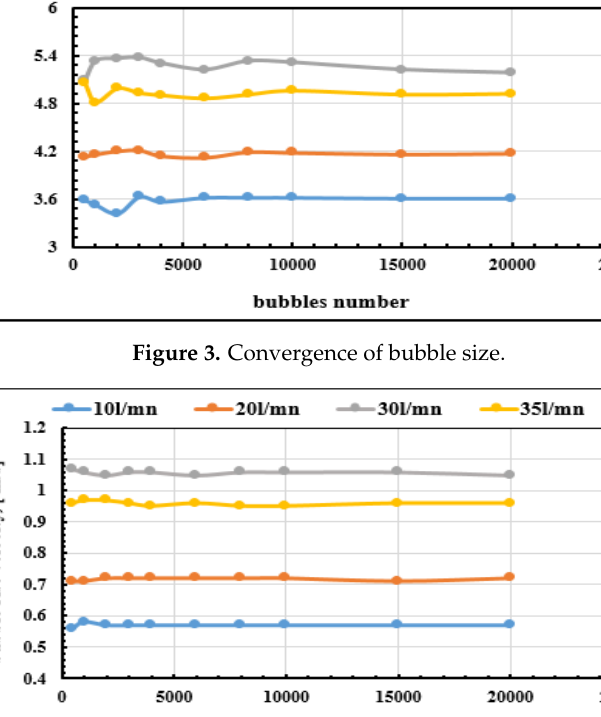
Figure 4. Convergence of bubble rise